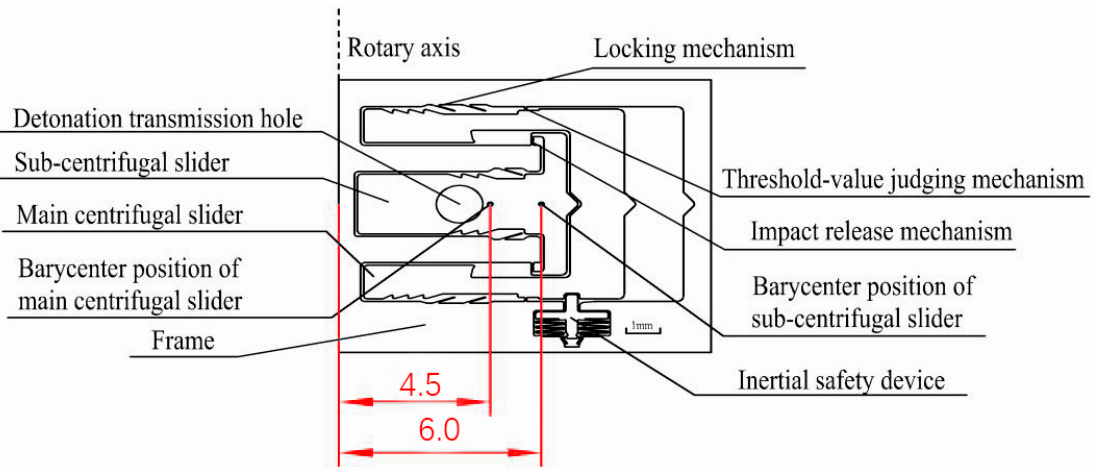
Figure 1. The MEMS safety and arming device (S&A) overall structure.